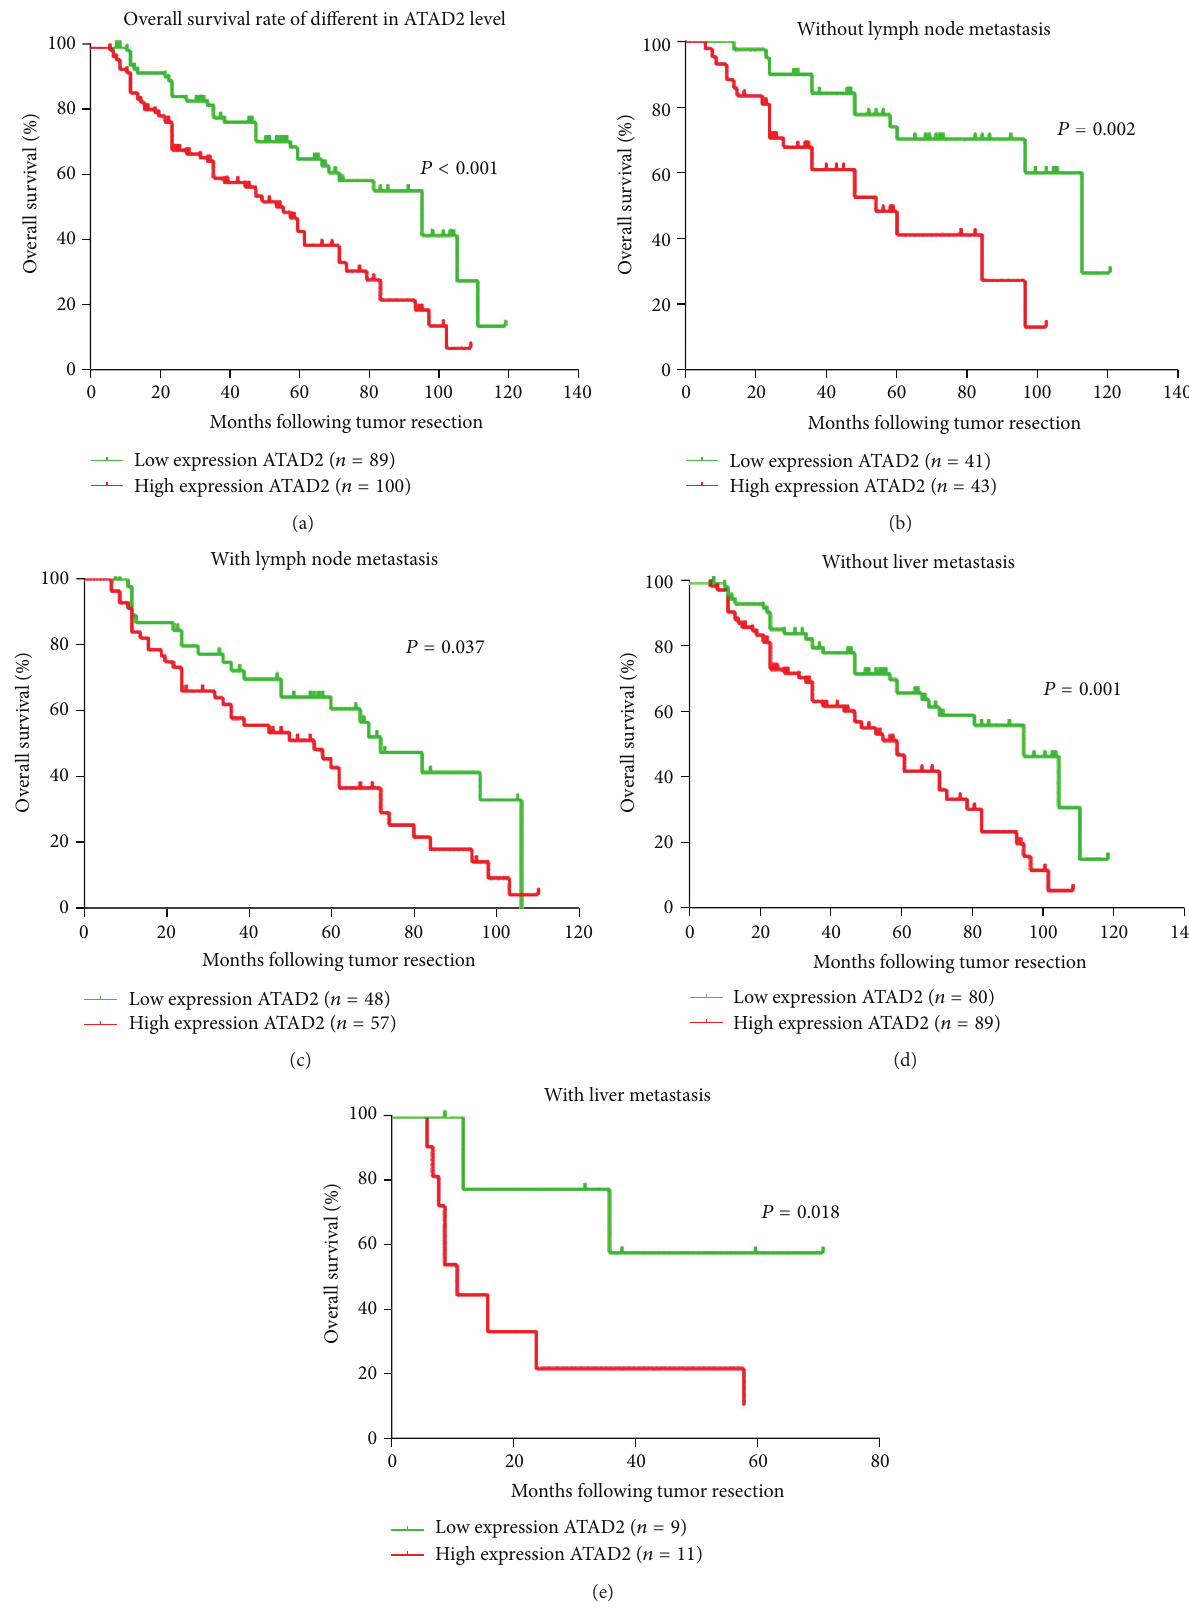
Figure 3: ATAD2 is correlated with overall survival rate in CRC patients. (a) Kaplan-Meier survival curves show high expression level of ATAD2issignificantlycorrelatedwithpoorsurvivalofCRC.(b)–(e)CorrelationbetweenATAD2expressionandpatientsurvivalincolorectal cancer is independent of lymphatic metastasis and liver metastasis. 𝑃 values were calculated using the log-rank